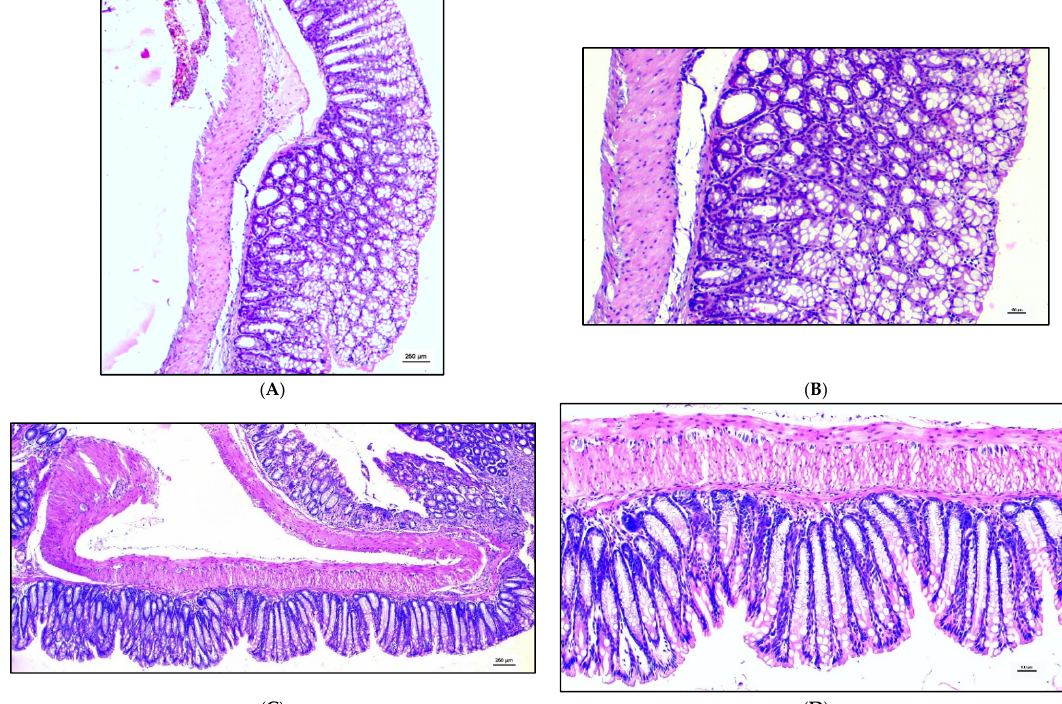
Figure 4. Histopathological findings regarding colon of mice treated for 7 days with Saline solution [( A ) Control group post-TNBS (4×), magnification 4×; ( B ) Control group post-TNBS (10×), magnification 10×, histological score 6] or bovine colostrum [( C ) Bovine Colostrum group post-TNBS (4×), magnification 4×; ( D ) Bovine Colostrum group post-TNBS (10×), magnification 10×, histological score 4] and then inoculated with TNBS show significant high but not always a constant amount of diffuse inflammation. The structure of the mucosa often appears modified by a massive diffuse inflammatory infiltrate of lymphocytes which involves also the submucosa and the intestinal wall. In the BC group, the diffuse inflammatory infiltrate of lymphocitary cells reaches the submucosa. Panels ( A , B ): enteritis with a high grade of diffuse inflammation and massive lymphocyte infiltration of all structures of the colon. The architectural structure of the mucosa is modified by the infiltration of the inflammatory cells. The submucosa, the intestinal wall and the serosal parts appear to be involved by the lymphocytary cells. Panels ( C , D ): enteritis with a medium grade of inflammatory infiltration involving the mucosa and the sub-mucosa of the